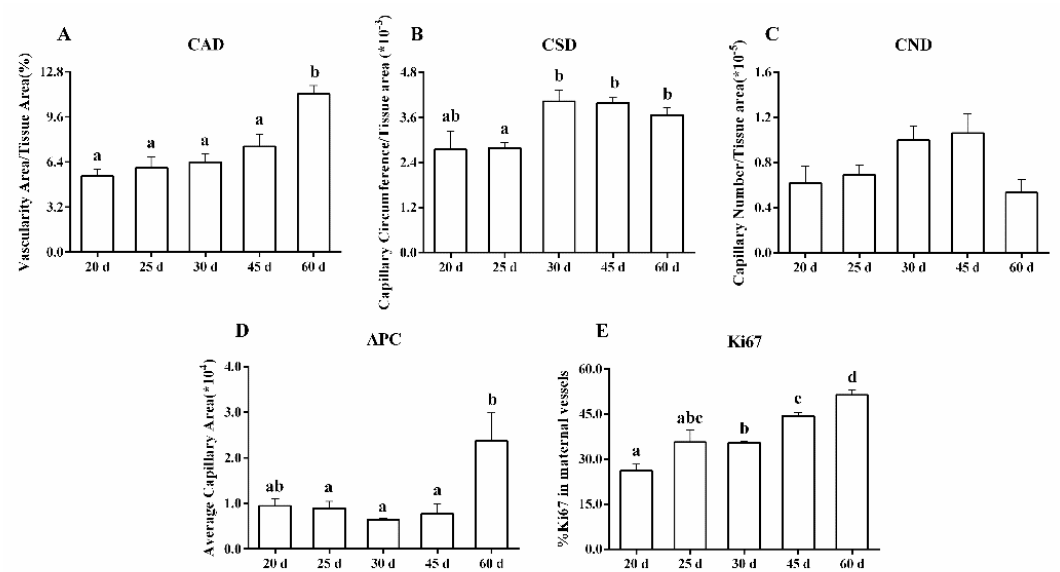
Figure 2. Measurements of vascularity including the capillary area density (CAD; A ), the capillary surface density (CSD; B ), the capillary number density (CND; C ), the area per capillary (APC; D ), and the proportion of proliferating cells (Ki67; E ), on days 20, 25, 30, 45, and 60 of pregnancy in the caruncle. a, b, c, d p < 0.002–0.05; values ± S.E.M. with different superscripts differ within specific measurement.